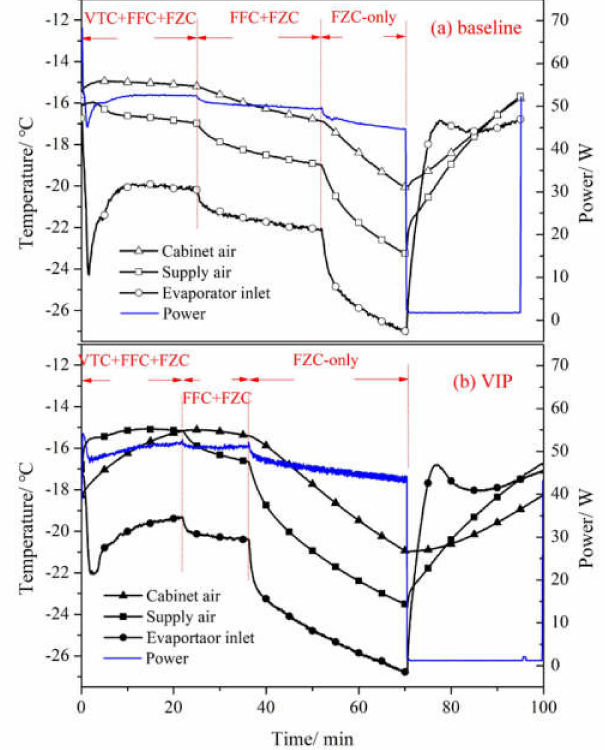
Figure 5. FZC cabinet air, FZC supply air, and evaporator temperatures during the 14th on / o ff cycle: ( a ) baseline case; ( b ) VIP case. (FZC means freezer compartment as defined in the